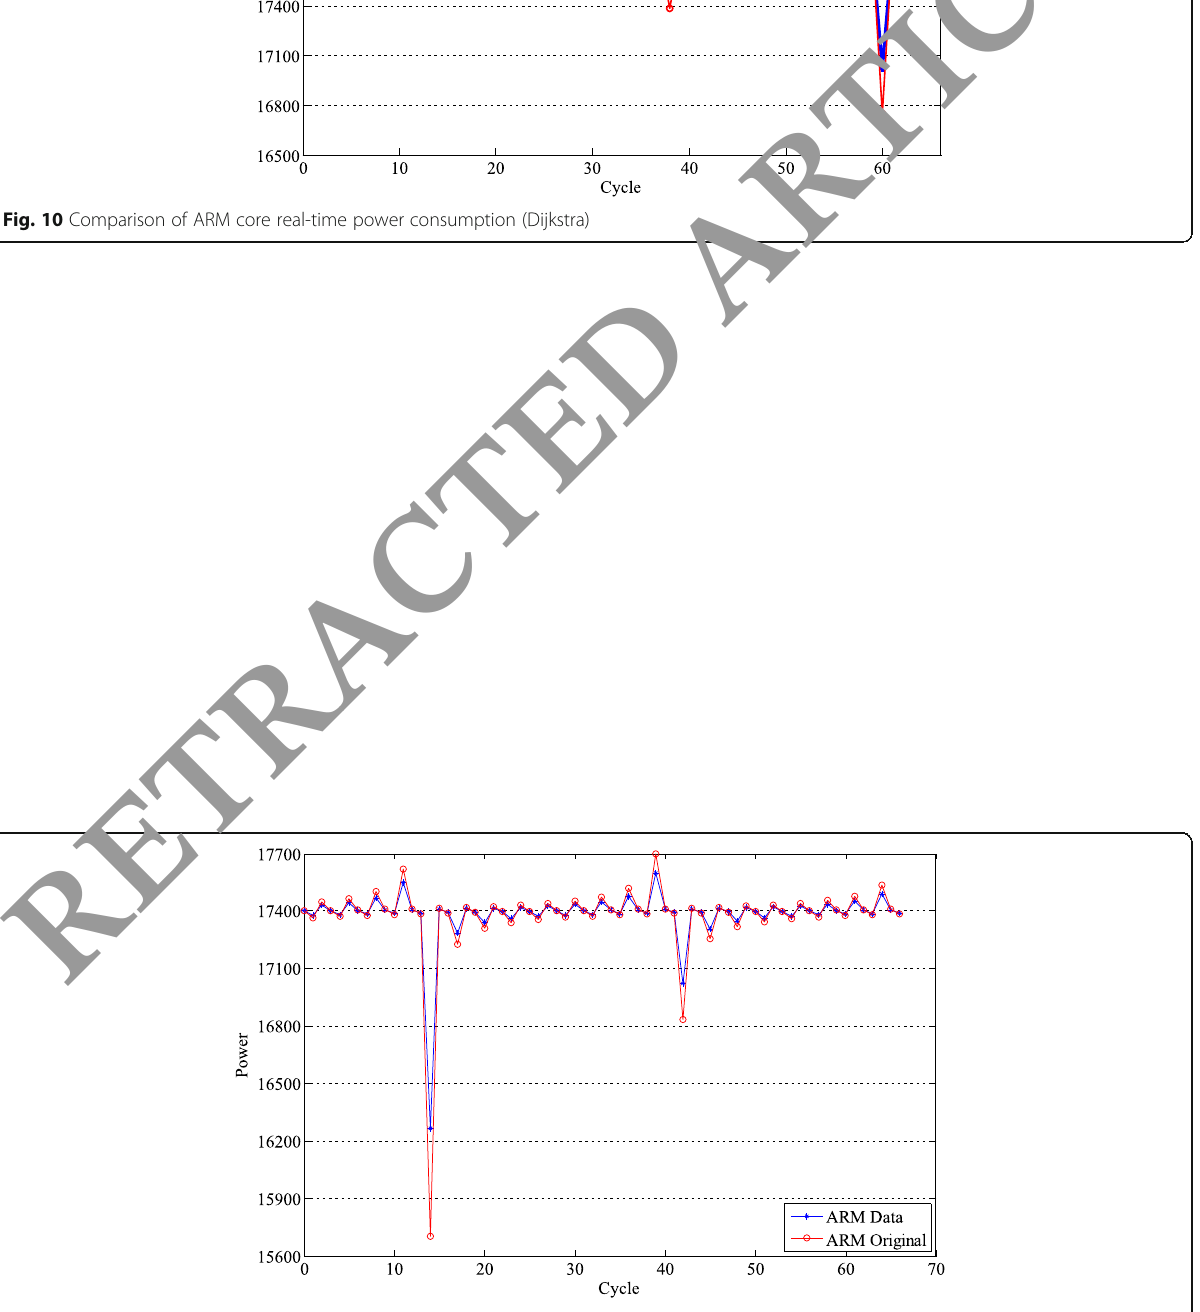
Fig. 11 Comparison of PISA core real-time power consumption (Dijkstra